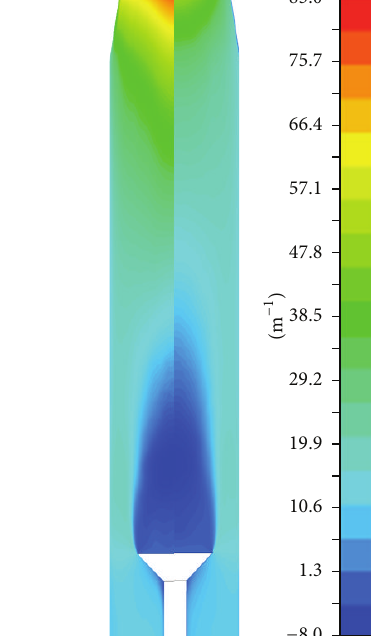
Figure 18: Instantaneous and mean progress variable and mean axial velocity contours for Fluent LES-ZIM-FL-M1-A and Zimont OF on mesh